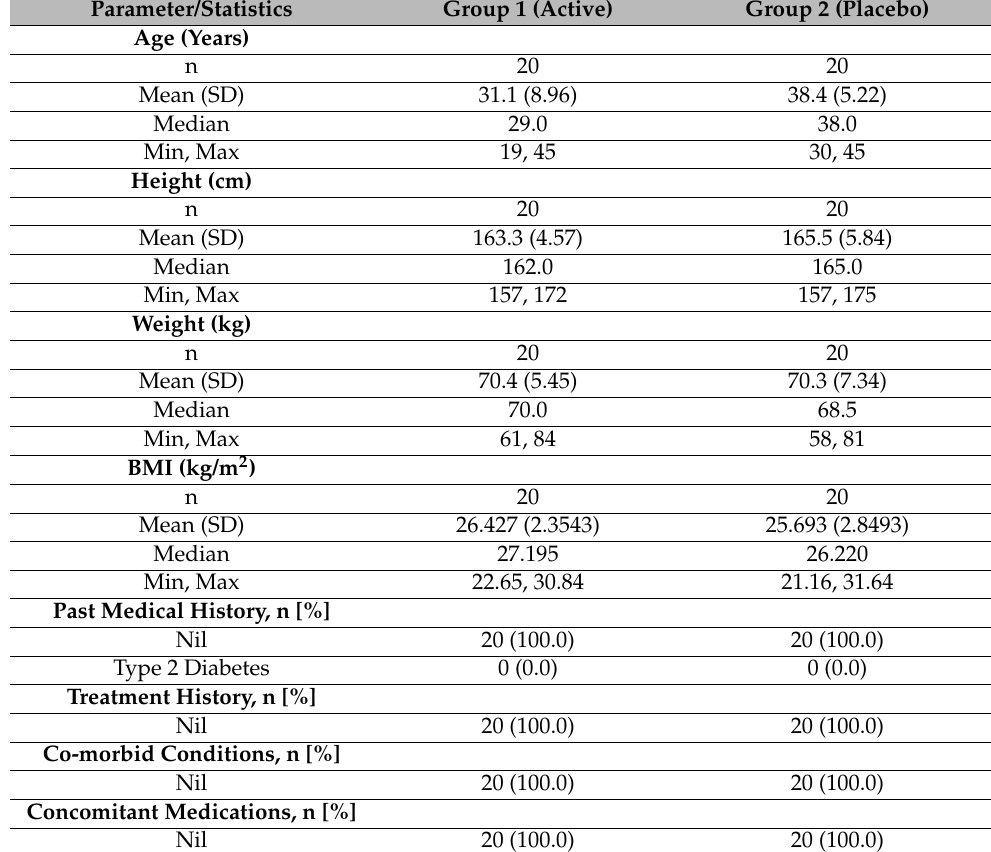
Table 2. Legend: BMI (body mass index), Min (minimum), Max (maximum).